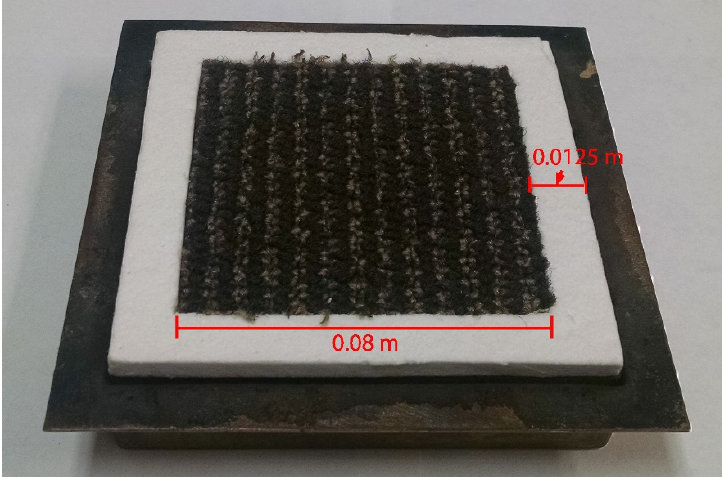
Figure 5. Photograph of a carpet composite sample mounted on the sample holder for CAPA tests.